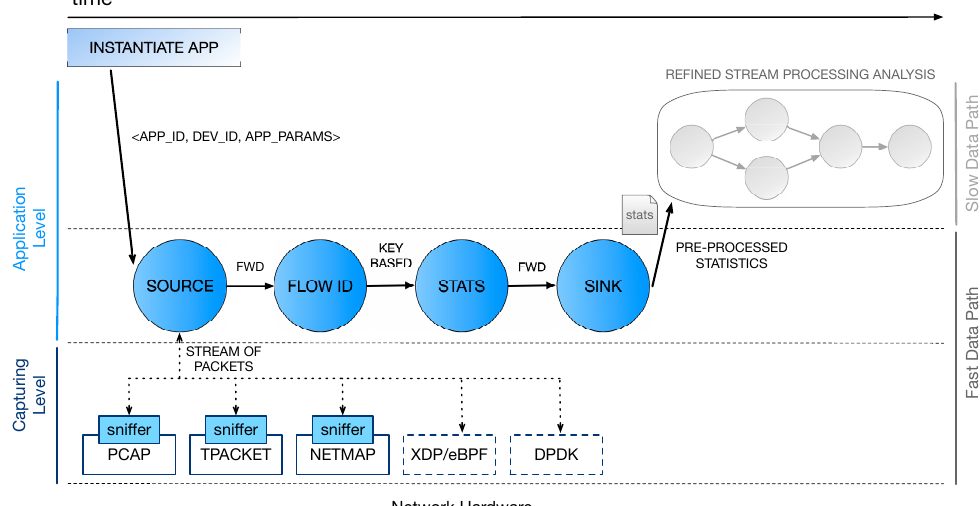
Figure 4. Processing pipeline of the example application. At the capturing level, three software packet-capturing tools are currently supported: pcap , TPACKET , and Netmap